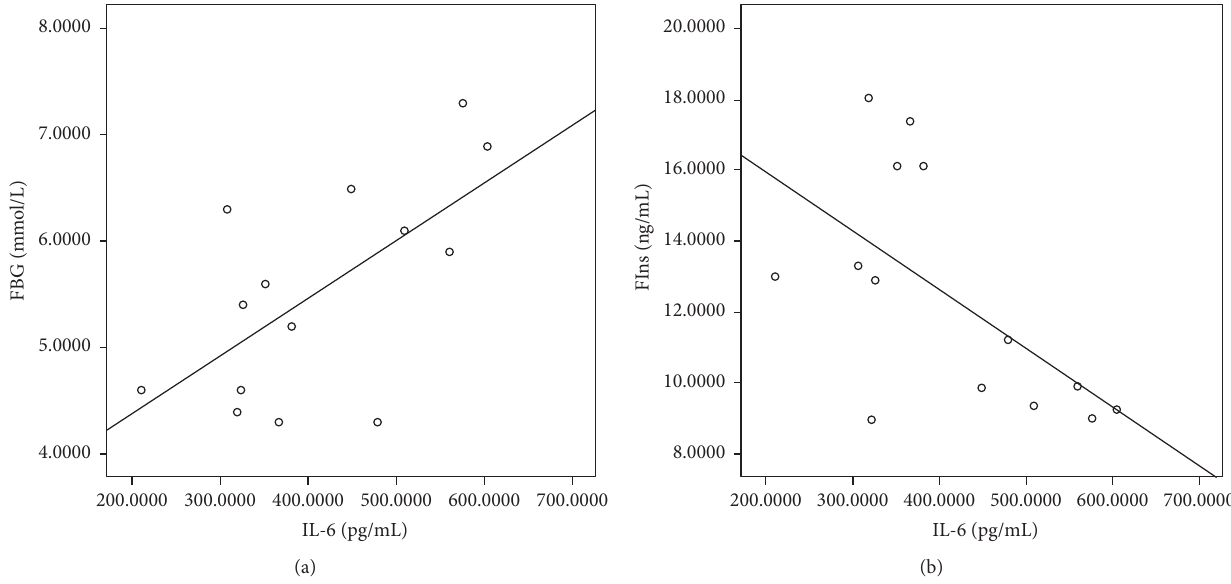
Figure 4: Correlation between IL-6 and FBG and FIns. The sera were harvested after day 17 of immunization. Levels of IL-6, FBG, and FIns were determined. The correlations between IL-6 and these factors in all the rats were analyzed by Spearman correlation test. 𝑝 value < 0.05 was considered as statistically significant. Data are representative of three independent